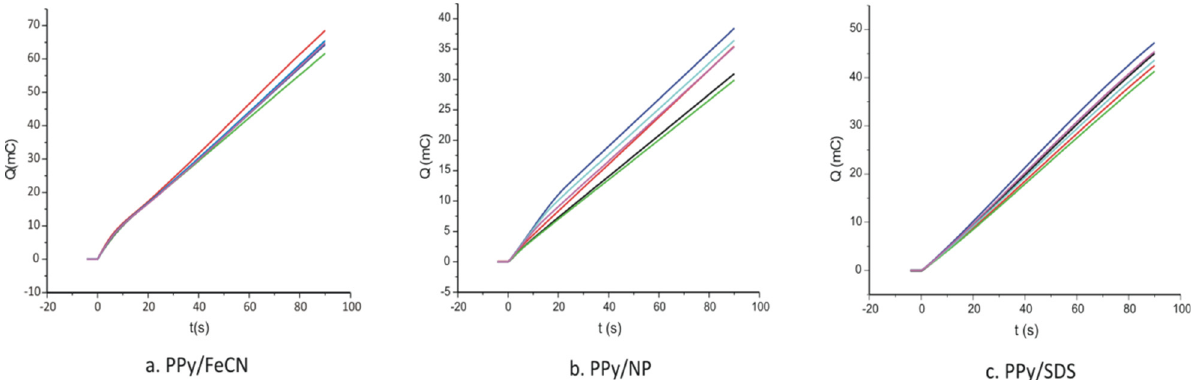
Figure 4. Q versus time (t) curves registered during electrosynthesis of six different sensors prepared in the same conditions in the presence of ( a ) FeCN, ( b ) NP, and ( c ) SDS.